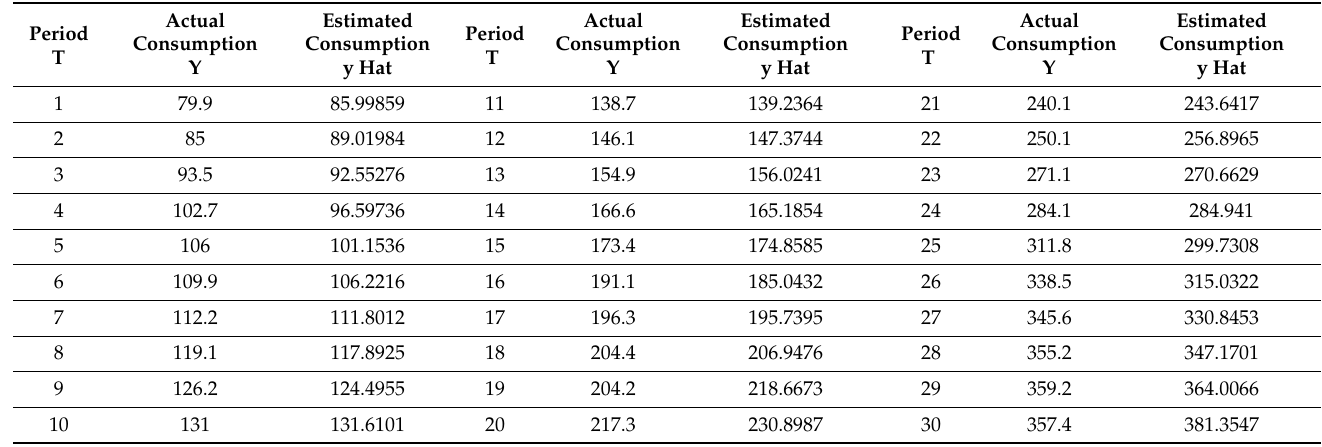
Table A3. Estimated electricity consumption by the second order polynomial.